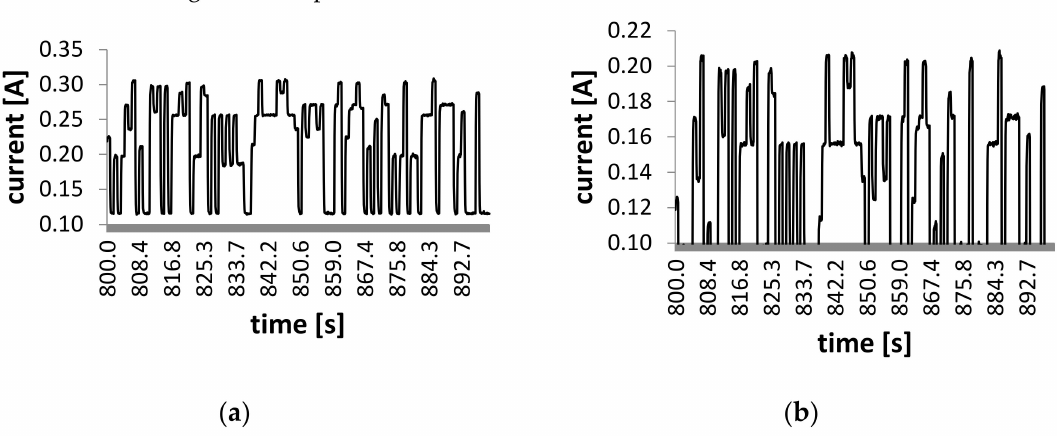
Figure 10. Li-ion battery current characteristics during its normal operation in a chosen period of time. Measurements of the physical object ( a ), simulation ( b